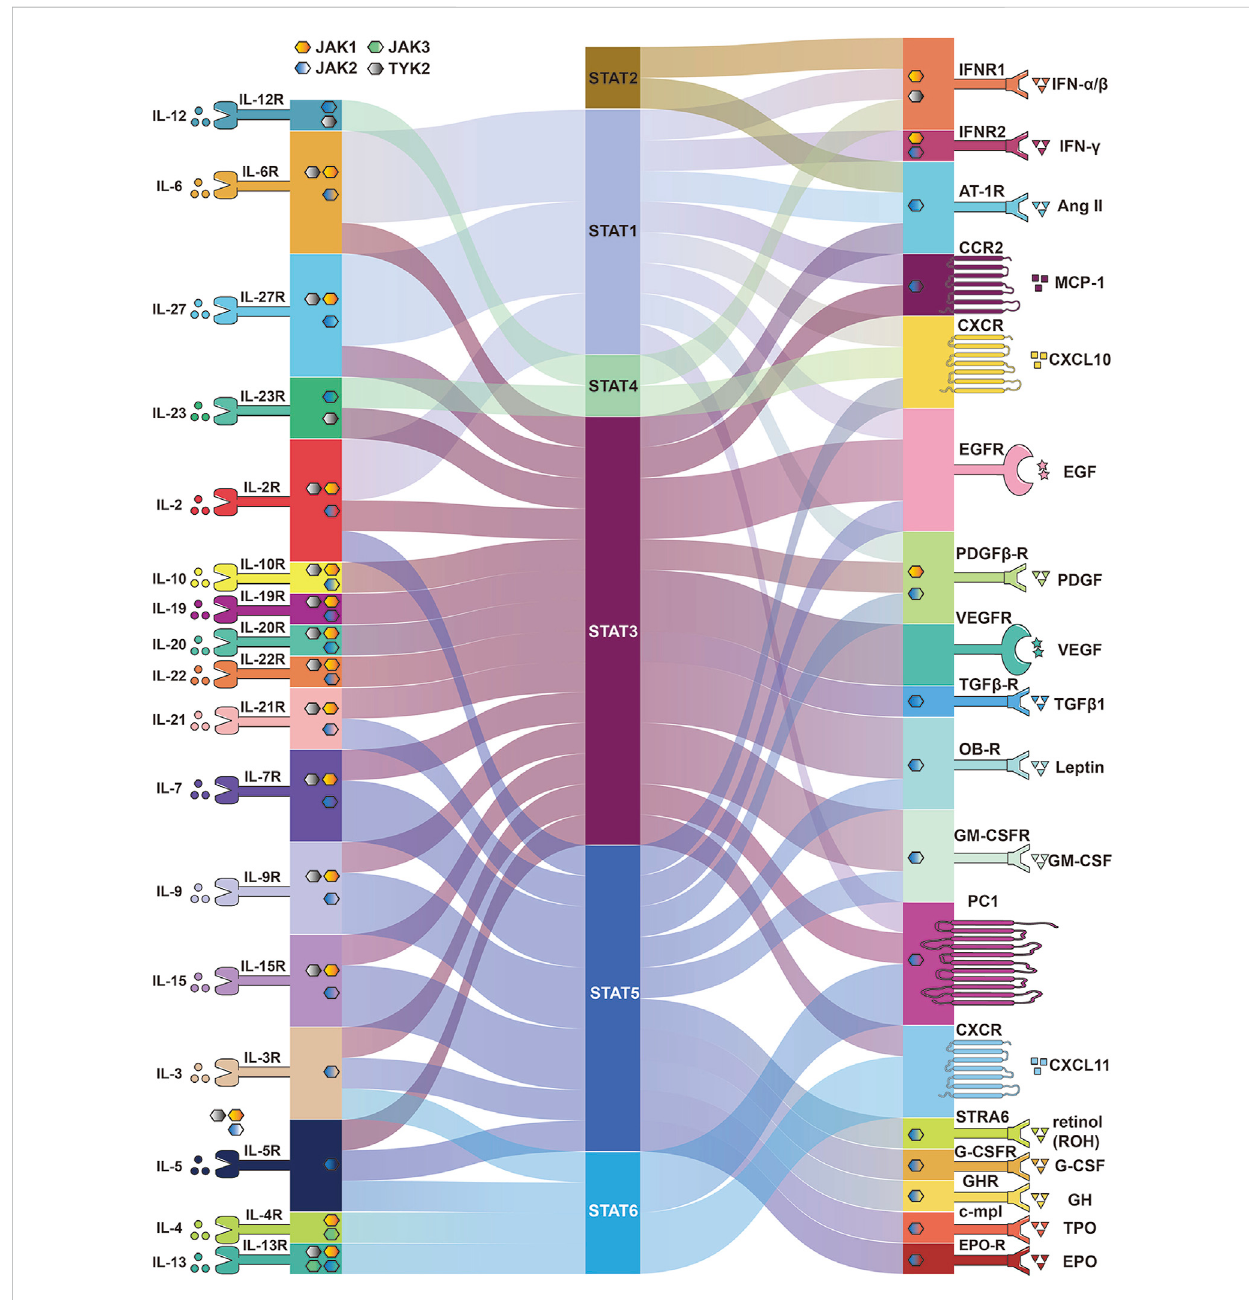
FIGURE 3 Membrane proteins and cytokines that activate the JAK/STAT pathway. Different membrane proteins and upstream cytokines phosphorylate different JAK and activate different STATA pathways. Some membrane proteins do not require JAK to activate STAT.